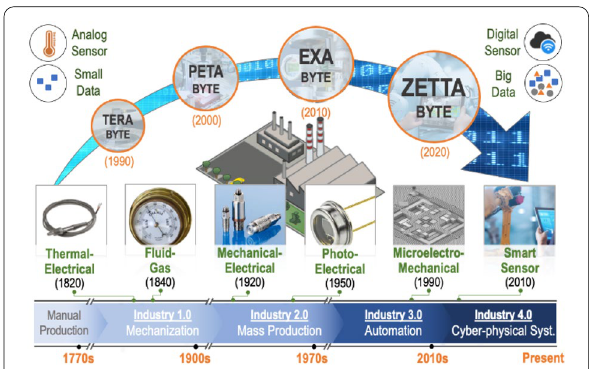
Figure 1 Evolution of manufacturing, sensing technology and big data, adapted from Ref. [6]